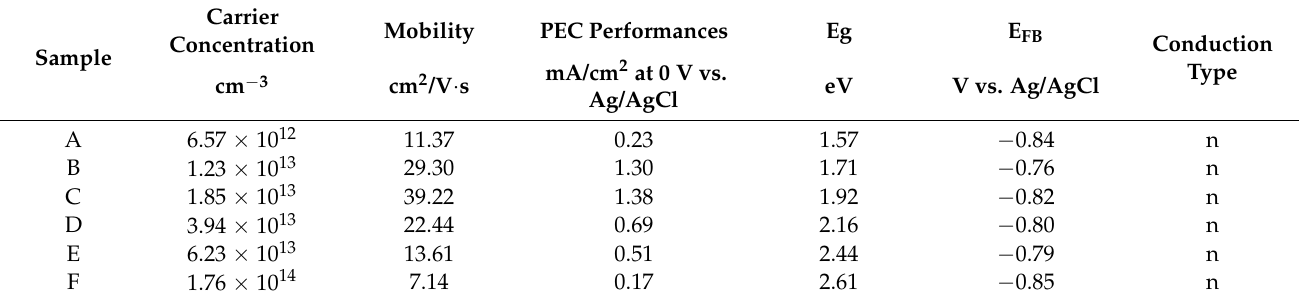
Room-temperature Hall measurements with a magnetic flux of 0.57 T were employed to measure the conduction type, carrier concentration, and mobility of the samples on glass substrates. All samples are n-type semiconductors, which is consistent with previous studies [10,17,25,29]. The carrier concentrations and carrier mobilities of samples were in the ranges of 6.57 × 10 12 –1.76 × 10 14 cm − 3 and 7.14–39.22 cm 2 /V · s, respectively. Detailed results are shown in Table 2. The carrier concentrations of samples increased with an increase in Zn content in the samples, while the mobilities of samples increased with increasing Zn content in the samples when the [Z]/[Sn] molar ratio of less than 0.2 was in the reaction solution. After that, the mobility decreased with an increase in the Zn content in the precursor solution. The possible reason is due to the pinholes or cracks formed in the samples, as shown in Figure 2. The pinholes or cracks formed in the samples are the defects that may result in the decrease in the mobilities of the samples and therefore decrease their PEC performances [21]. The carrier concentration and mobility for Ag 8 SnS 6 are 10 12 cm −